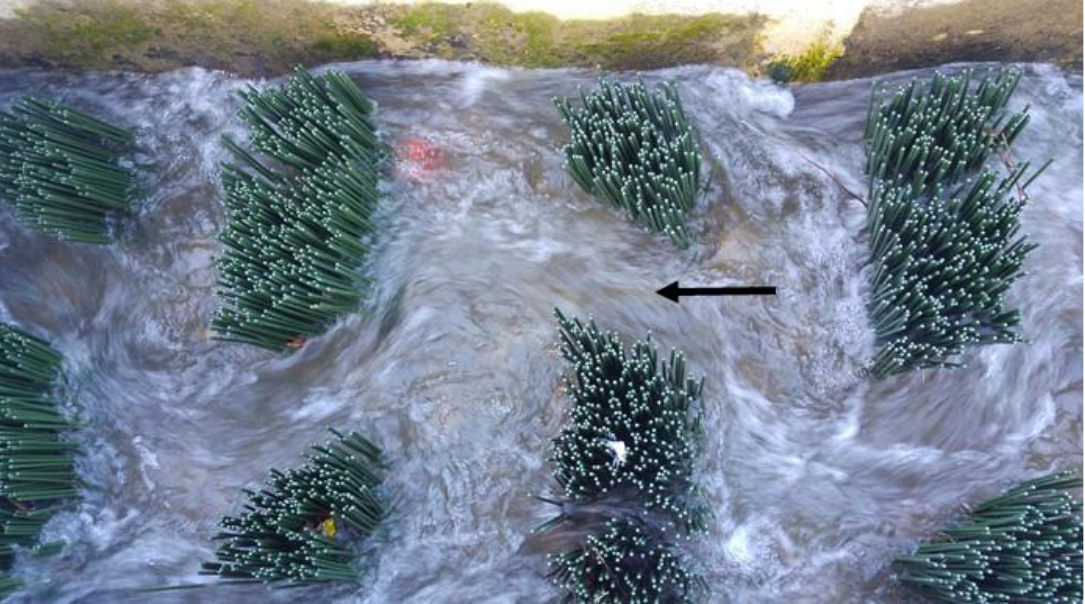
Figure 3. S flow in diagonal brush fish pass at Incirli Small Hydropower Plant. Bristle clear height is 0.37 m. Young modulus of elasticity of bristles is E = 973 MPa.